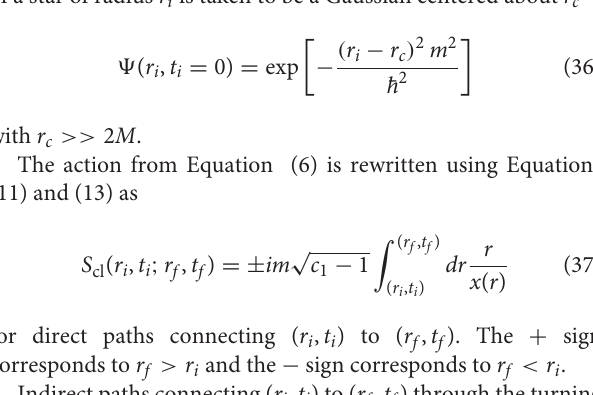
FIGURE 2 | (A) v vs. r and (B) v vs. u are shown for space-like and time-like paths with v i 0 that pass through P ( u P = point located inside the apparent horizon. (C) The c 1 values for indirect space-like paths in the region between b ′ 6 and b ′ 7 from which point P can be reached are displayed for each u i . No paths exist beyond r where the two roots merge into